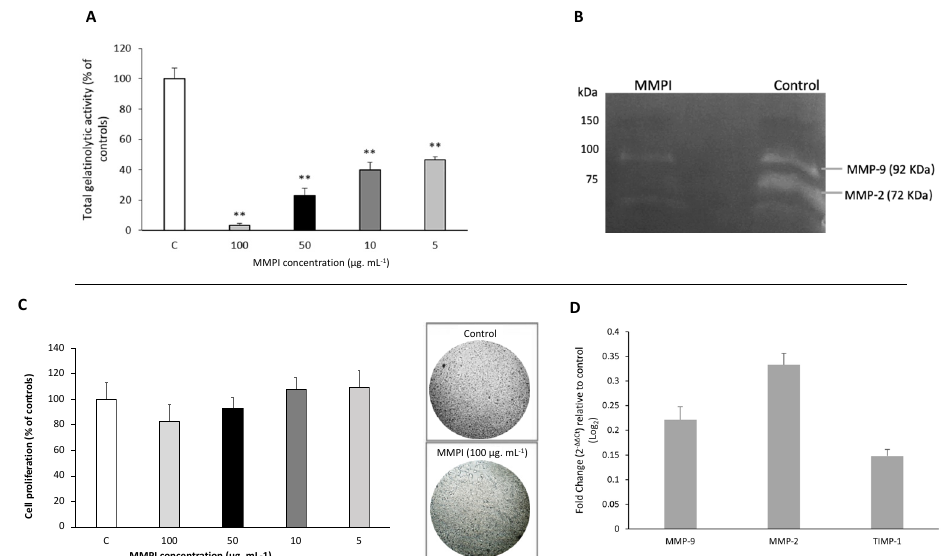
Figure 4. L. albus MMPI effect on MMP-9 and MMP-2 activity, cell proliferation, and gene expression in HT29 cells. ( A ) Dose-effect of the isolated L. albus MMPI on total gelatinolytic activity. The isolated MMPI was added at concentrations of 100, 50, 10, and 5 µg·mL − 1 and gelatinolytic activity was measured by the DQ fluorogenic assay. Gelatinase activities are expressed as percentage of controls. ( B ) Representative image of the zymographic profiles of specific MMP-9 and MMP-2 activities. White bands are consistent with higher gelatinolytic activities. HT29 cells were exposed to 50 µg·mL − 1 of the MMPI, and extracellular extracts were loaded on 12.5% ( w / v acrylamide) polyacrylamide gels co-polymerized with 1% ( w / v ) gelatin. ( C ) HT29 cell growth after 48-hour exposure to different concentrations of the L. albus MMPI and representative picture of HT29 cells morphology in controls and in the highest MMPI concentration. Cells were grown in the presence of 100, 50, 10, and 5 µg protein mL − 1 and stained with MTT. Values are expressed as a percentage of the control. ( D ) L. albus MMPI influence on MMP-2, MMP-9, and TIMP-1 gene expression. Cells were grown in the presence of 50 µg protein·mL − 1 and transcripts were quantified by real-time PCR (RT-qPCR). Relative gene expression values are presented as log 2 -fold-change values in relation with the control conditions, using as reference gene Beta-actin. Data were normalized in relation to controls and the graphic is expressed as 2 −ΔΔ Ct values. All values represent the averages of at least three replicate experiments ( n = 3) ± SD in each assay. ** p < 0.001 when compared to controls.